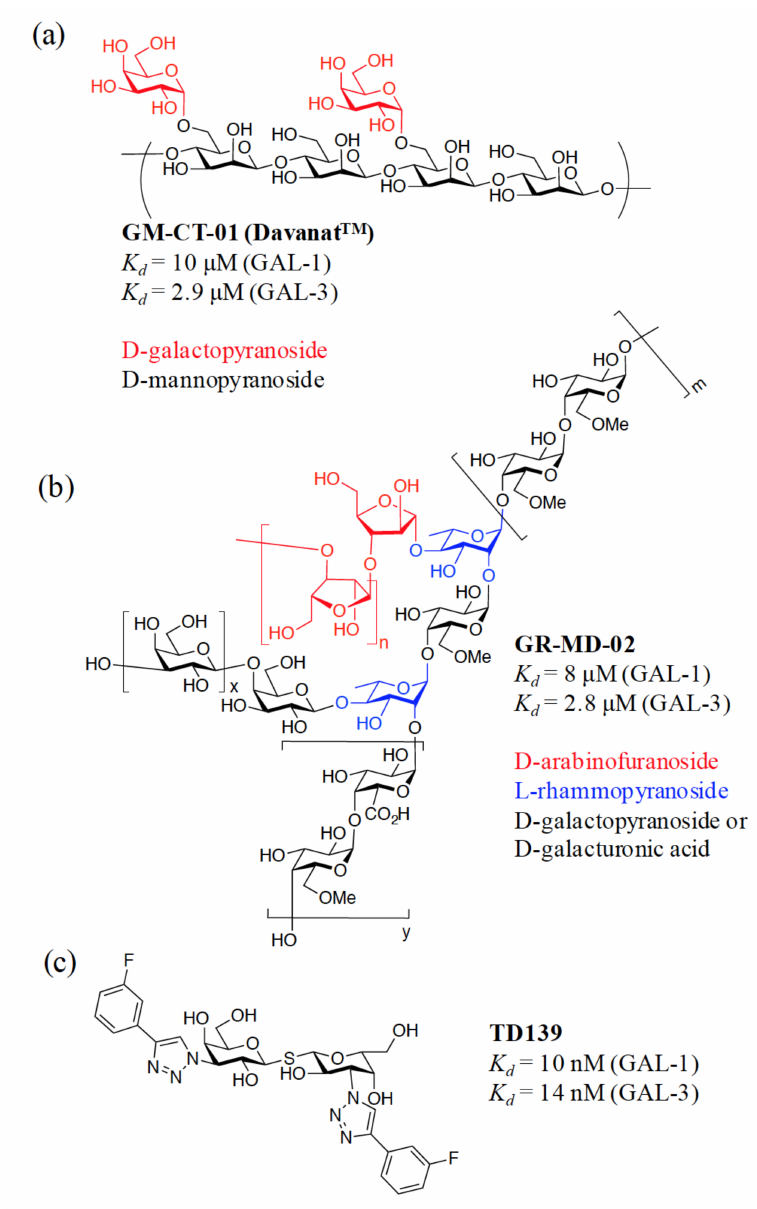
Figure 2. Structures of GM-CT-01, GR-MD-02, and TD139 that have been examined in clinical trials for GAL-3-related